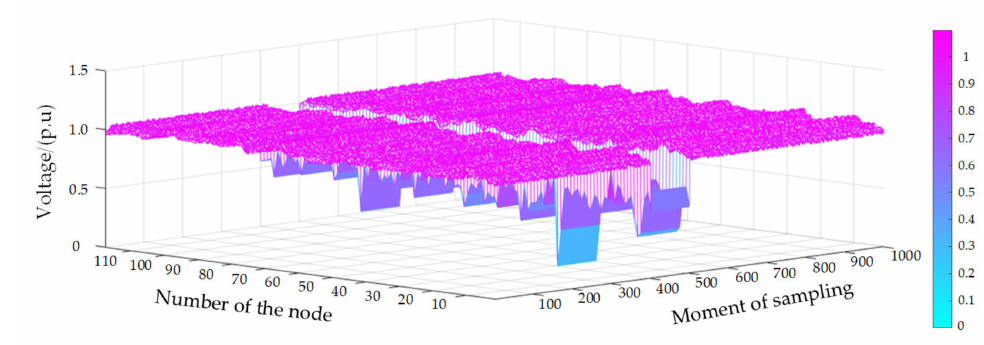
Figure 5. Variation of node